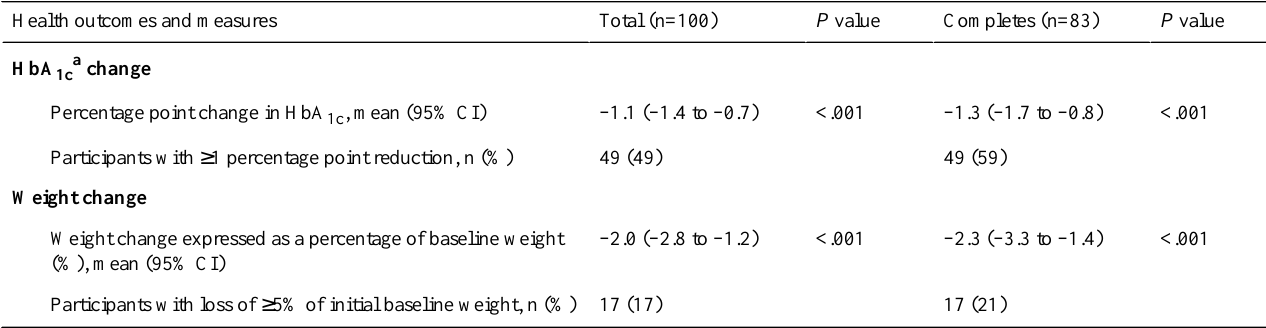
Table 4. Changes in health outcomes at follow-up compared to baseline for participants who reached